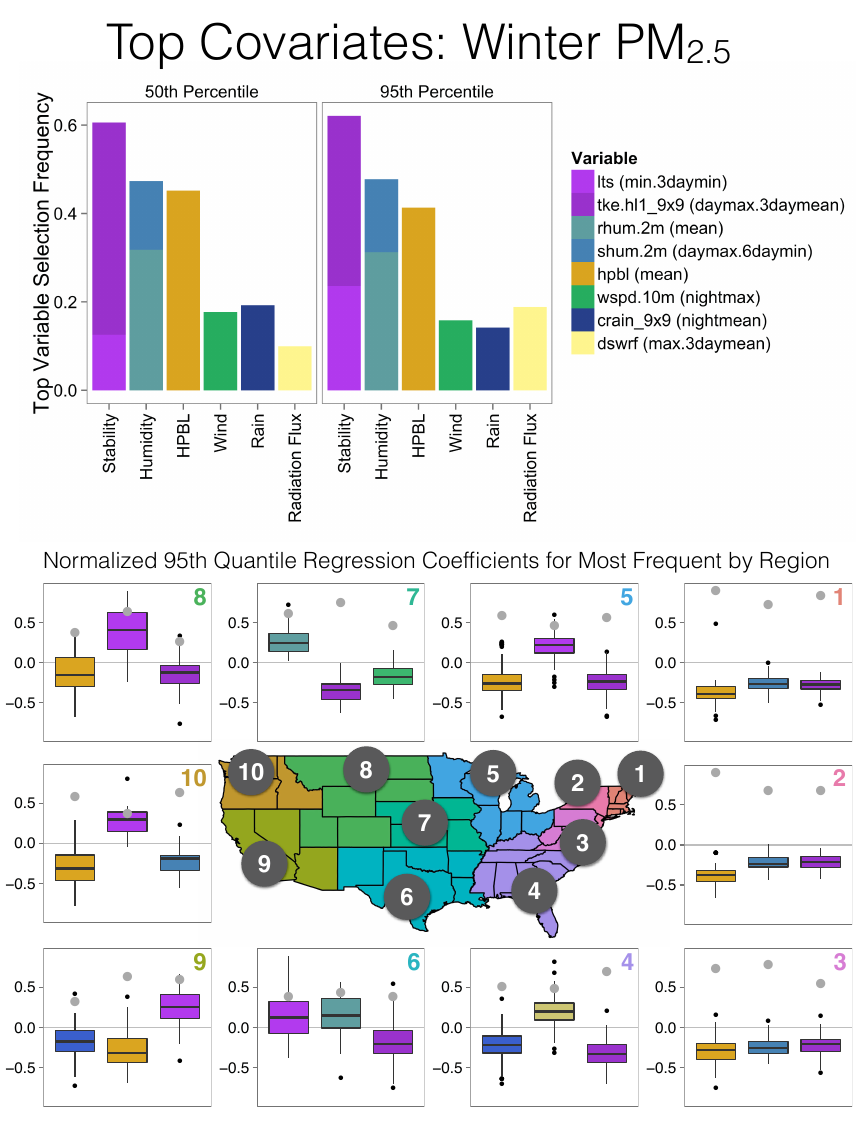
Figure 8. Same as for Fig. 4 but for winter PM 2 . 5